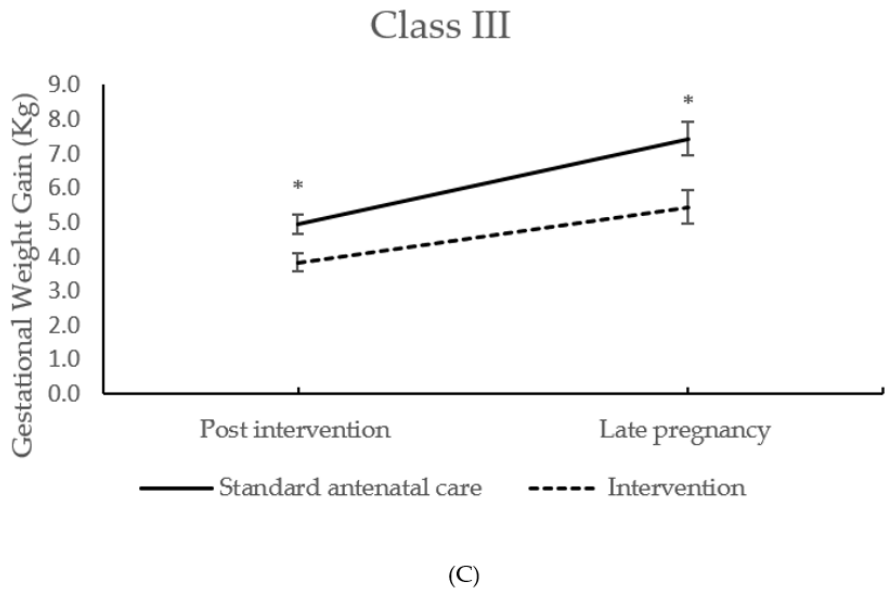
Figure 1. GWG at 27 + 0 –28 + 6 weeks’ gestation and at 34 + 0 –36 + 0 weeks’ gestation, for participants randomised to standard antenatal care and intervention groups in ( A ) obesity Class I, ( B ) obesity Class II , ( C ) obesity Class III. Data points are means with standard error bars. * p < 0.05 to be taken as significant.